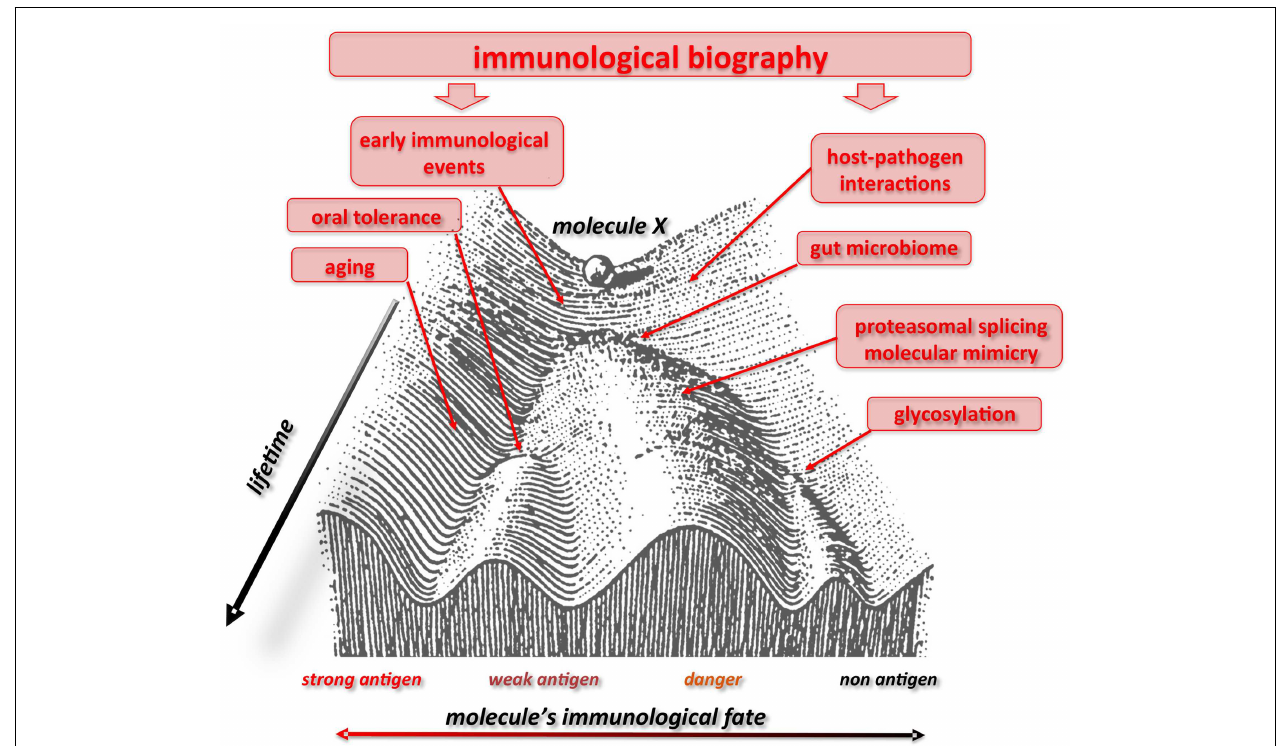
geography, and context (valleys, bifurcations, attractors), it can be perceived by the immune system as a strong, weak or non-antigen, a danger signal, an allergene, etc, i.e., showing different and changing degrees of immuno- genicity all through the individual’s course of life. Consequently, what today could elicit an immunogenic response, tomorrow would not. Figure modified from Ref. (192), originally presented inWaddington, C. H. Organisers & genes. 1940, Cambridge: Cambridge University